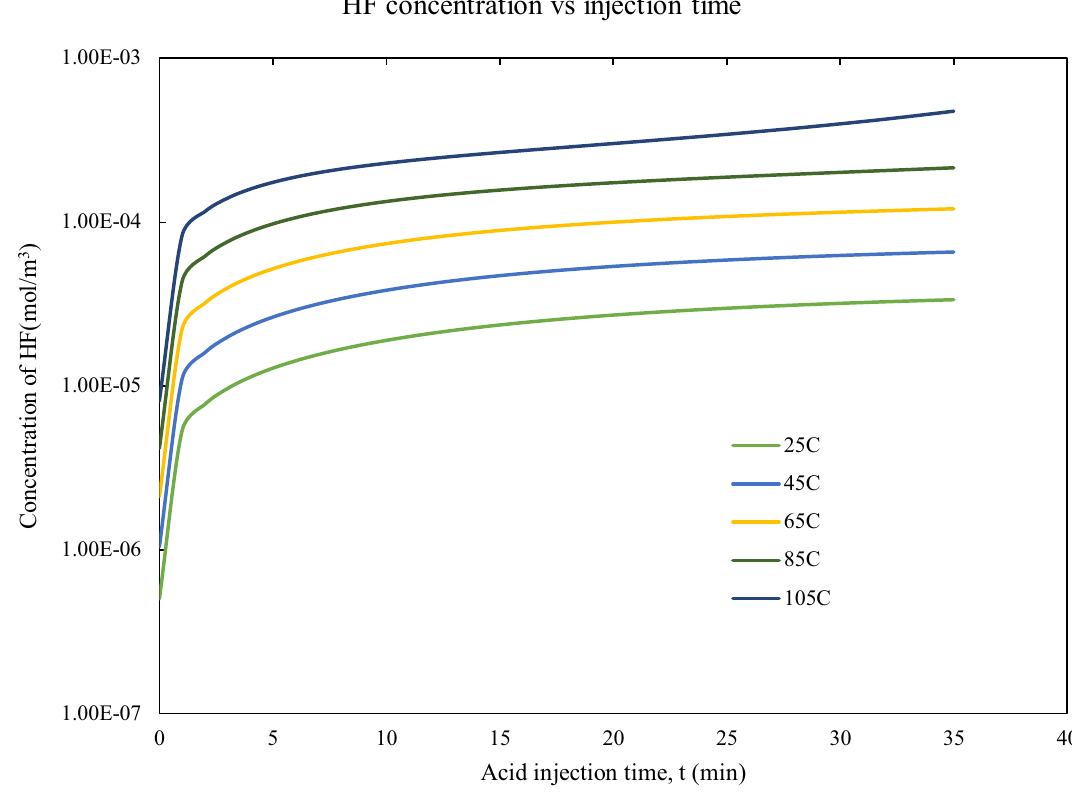
Fig. 14 The effect of temperatures on HF concentration along acid injection